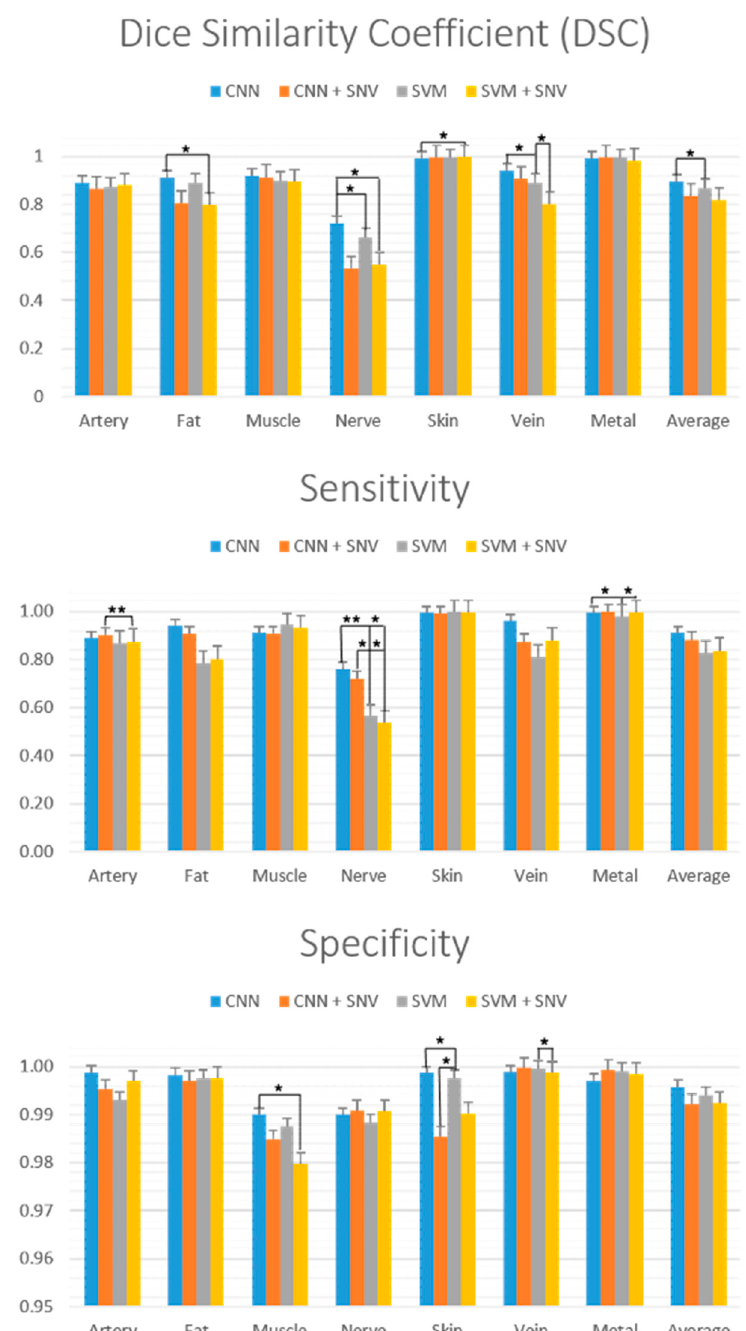
Figure 8. Performance of the four classification models in terms of Dice similarity coefficient (DSC) ( top ), sensitivity ( middle ) and specificity ( bottom ). Error bars represent 1 standard error. Brackets with * and ** denote statistical significance at p < 0.05 and <0.01 respectively.